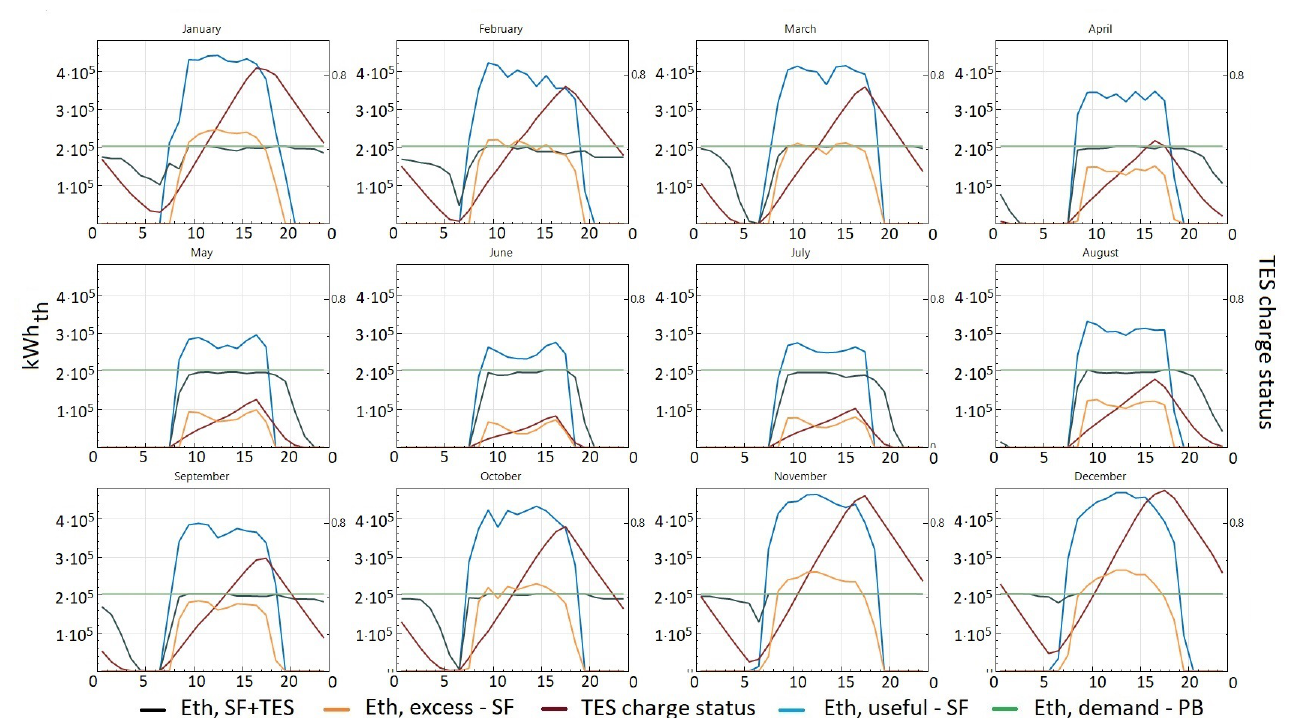
Figure A1. Average monthly time variation of the main energy parameters: Site 1 case.